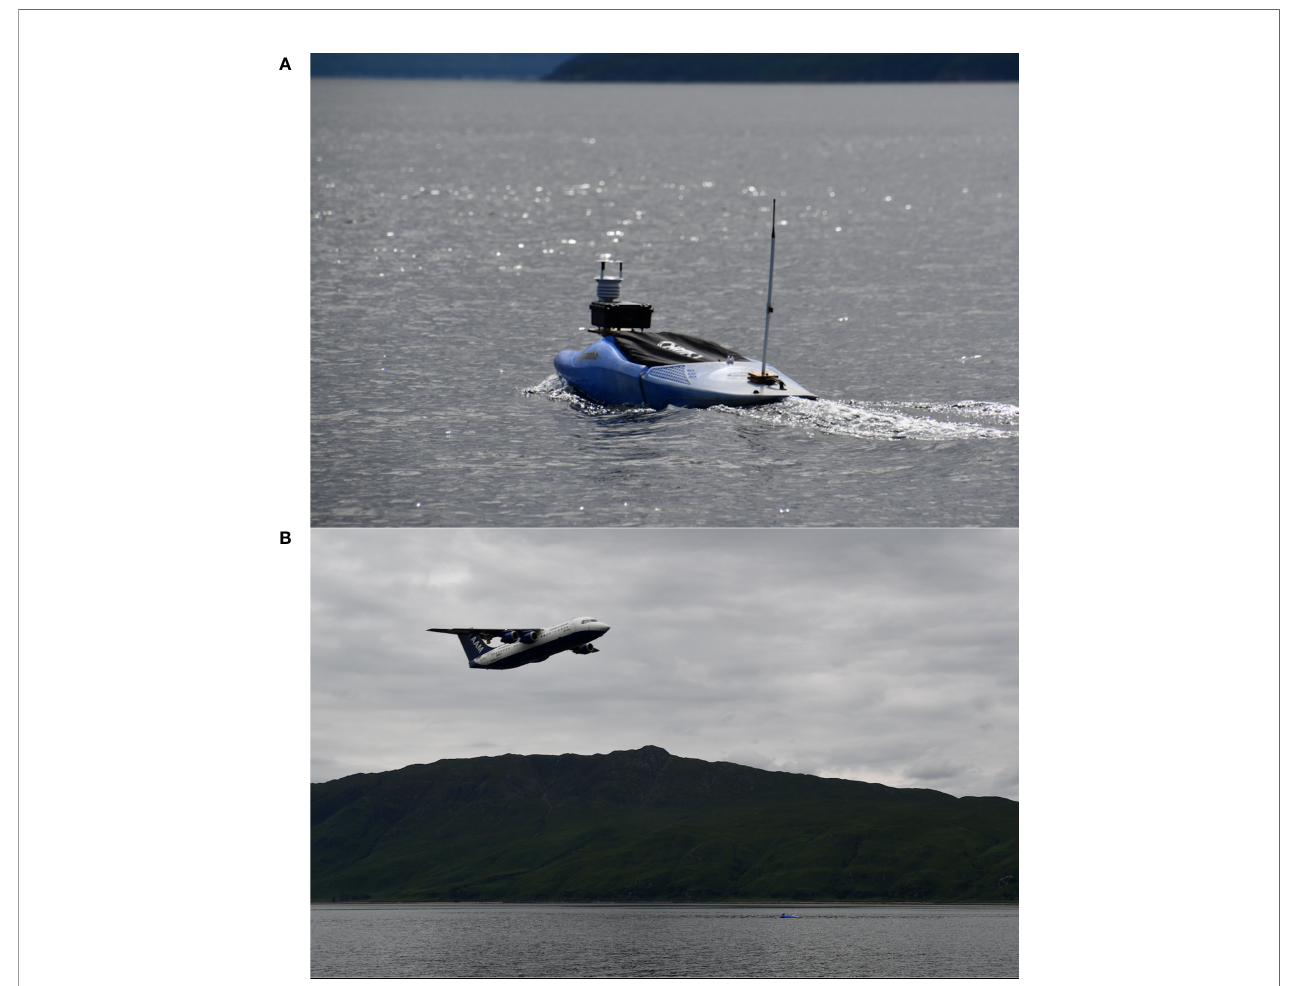
FIGURE 10 | ImpYak ASV in loiter mode on Loch Linnhe in north east Scotland on 9th July 2021 (A) , whilst working in conjunction with the FAAM aircraft (Facility for Airborne Atmospheric Measurements, https://www.faam.ac.uk) (B)